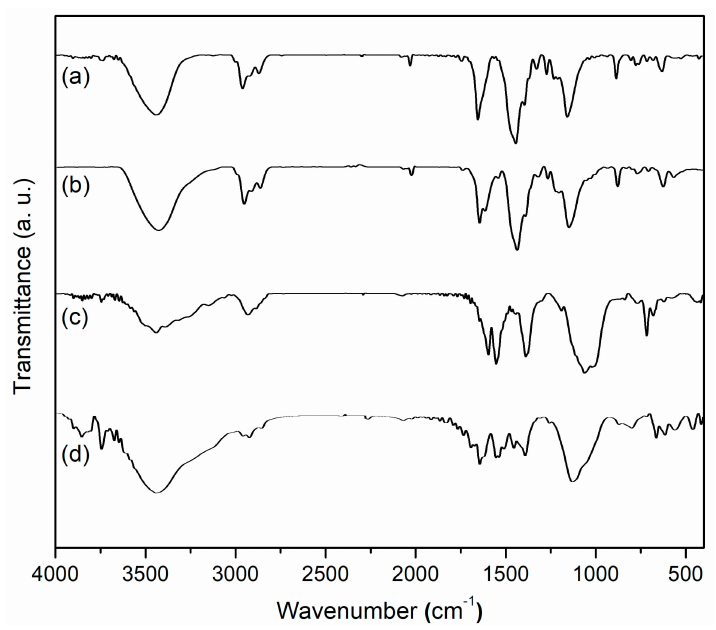
Figure 2. FT-IR spectra of ( a ) L1, ( b ) Mn1, ( c ) amino-LDH, ( d )